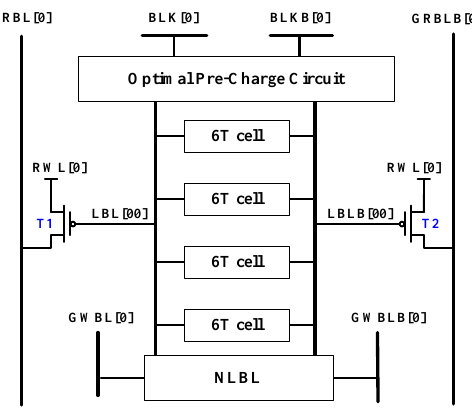
Figure 1. The proposed local bit-line 6 T SRAM block diagram.